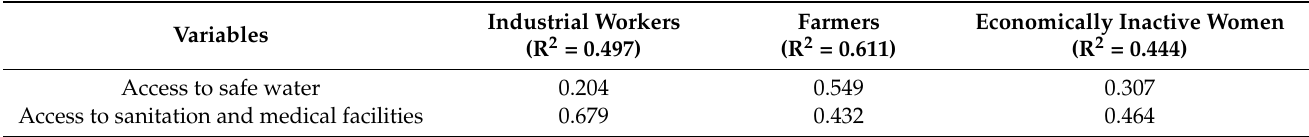
Table 8. Significant predictors of access component.